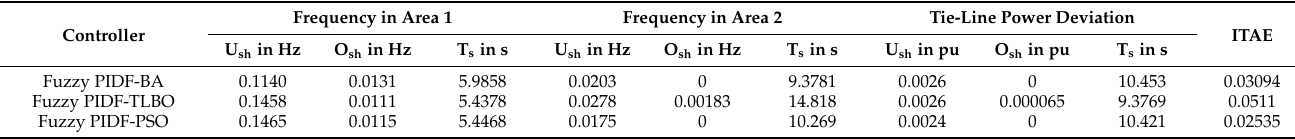
Figure 23. Tie-line power deviation ( ∆ P tie ) under parametric uncertainties. Table 22. Frequency response performances with different controllers.